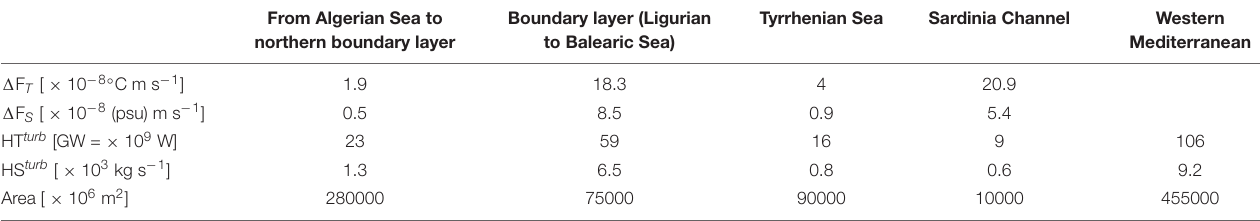
TABLE 4 | Mechanical turbulence estimates of the difference in temperature flux (cid:49) F T , and in the salt flux (cid:49) F S , between 1000 and 2000 m. From Algerian Sea to Boundary layer (Ligurian northern boundary layer to Balearic